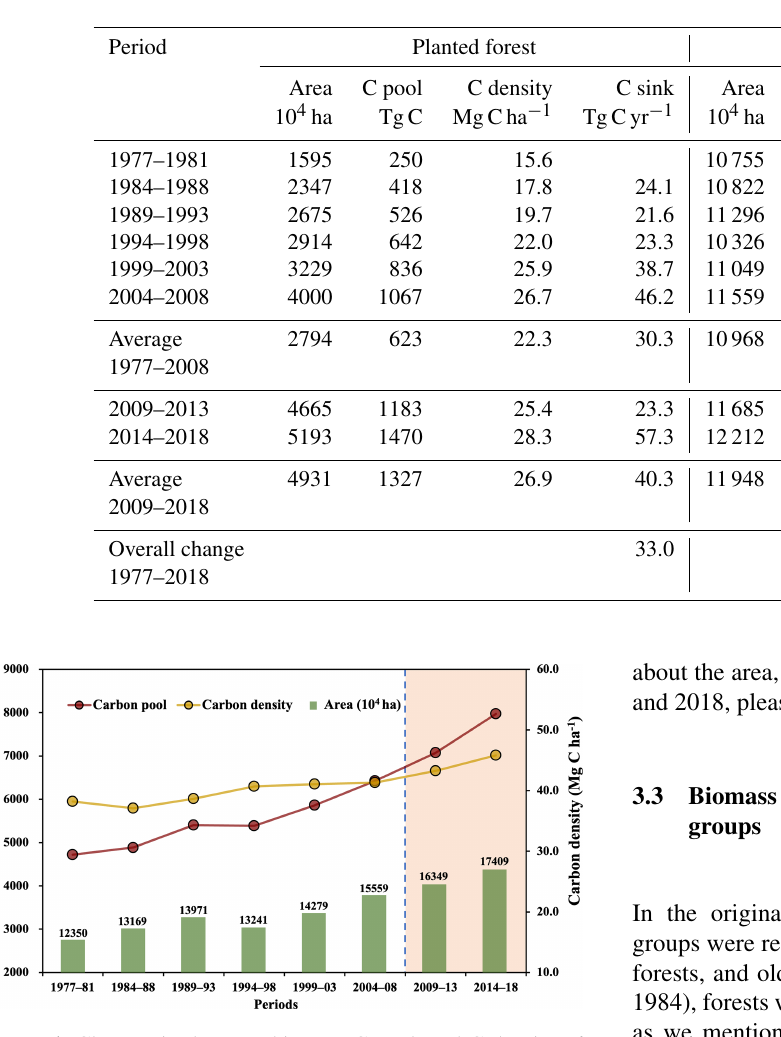
Figure 1. Changes in the area, biomass C pool, and C density of forests from 1977 to 2018. The pink box highlights the results of the recent